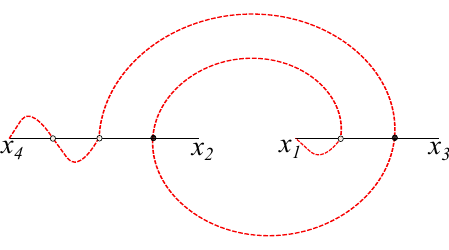
Figure 15 . Typical planar graphs producing UV divergent contribution to the four-point correla- . The black blobs denote the single-trace vertices with the coupling ξ 2 . The white tion function G C blobs denote both the single-trace ξ 2 vertices and the double-trace α 2 − ) and it vanishes at the fixed point. Similarly, for the correlation tion is proportional to ( ξ 2 α 2 2 − the contribution of analogous UV divergent planar graphs vanishes at the fixed point function G B through the same